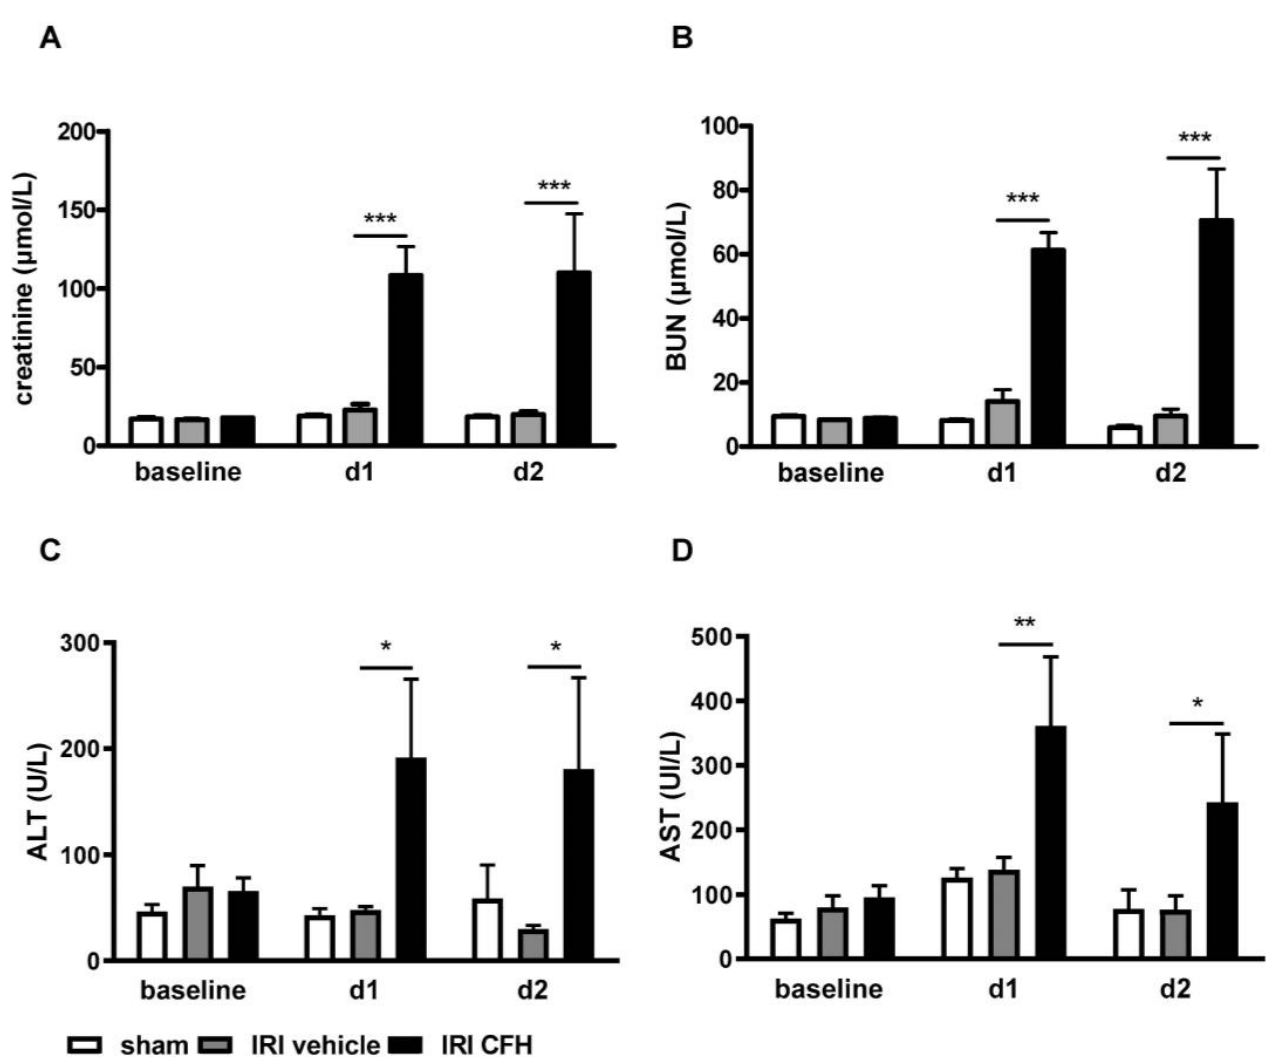
Figure 2. Serum creatinine ( A ), blood urea nitrogen (BUN) ( B ) and the liver enzymes ALT ( C ) and AST ( D ) in mice before (baseline) and at days 1 (d1) and 2 (d2) after sham surgery (white bar) and bilateral renal ischemia reperfusion injury (IRI) for 15 min with vehicle (grey bar) or cell free-hemoglobin (CFH, black bar) treatment. Bilateral renal IRI (with vehicle) did not cause acute kidney injury (AKI) in this model as evidenced by normal serum creatinine (( A ), grey bar) and BUN (( B ), grey bar) levels. However, CFH administration in this model of subclinical renal IRI caused overt AKI with marked increases in serum creatinine (( A ), black bar) and BUN (( B ), black bar) levels in this subclinical IRI model. Moreover, signs of distant organ injury such as elevation of the liver enzymes ALT (( C ), black bar) and AST (( D ), black bar) were observed after renal IRI with CFH administration. * p < 0.05, ** p < 0.01, *** p < 0.001.